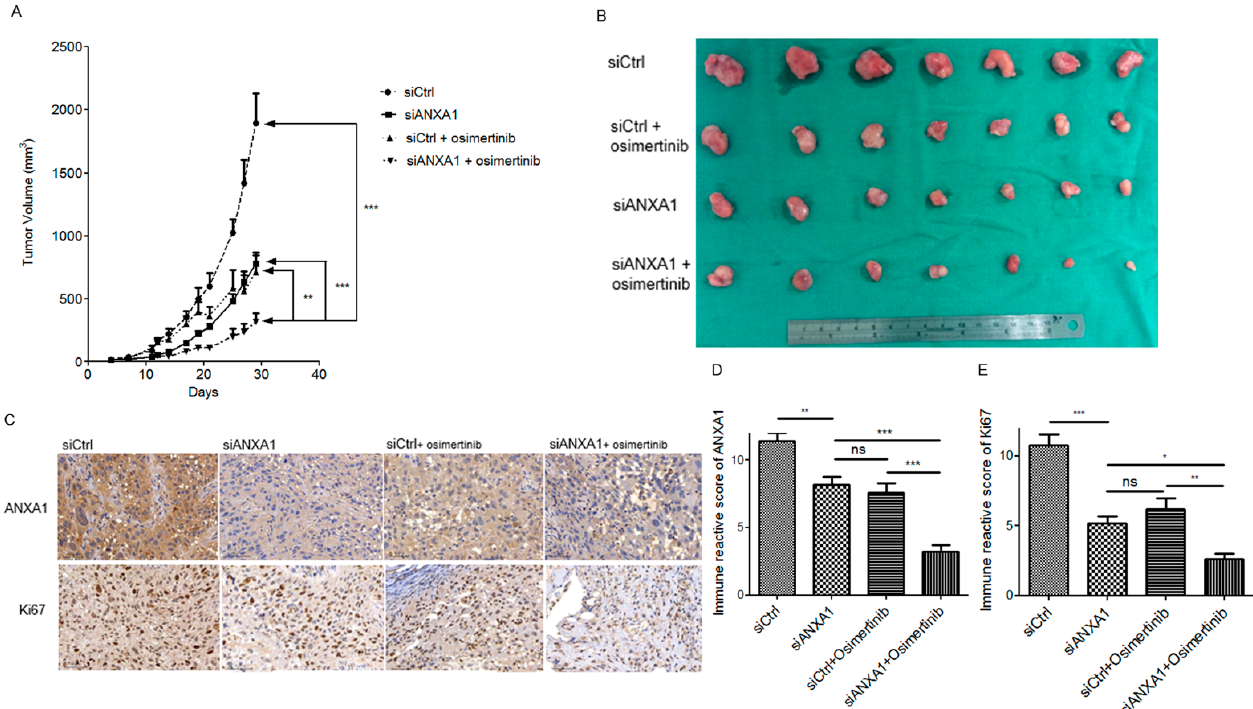
Figure 5. ( A ) Nude mice xenograft model of the H1975 lung cancer cells. The mice were injected intratumorally with non-target siRNA or ANXA1 siRNA with or without parenteral Osimertinib. The data were represented as mean tumor volume ± standard deviation ( n = 7 in each group). ( B ) Tumors of the H1975 xenograft model. ( C ) Representative graph of the ANXA1 and Ki67 IHC staining. Magnification: 200X. Scale bar: 20 µM. ( D ) Immune reactive score (IRS) of ANXA1. E. IRS of Ki67. The IRS data were represented as mean ± standard deviation ( n = 5 in each group). siCtrl: nontarget siRNA. siANXA1: ANXA1 siRNA. “ ns ” denotes nonspecific. “*” denotes p < 0.05; “**” denotes p < 0.01; “***” denotes p < 0.001.